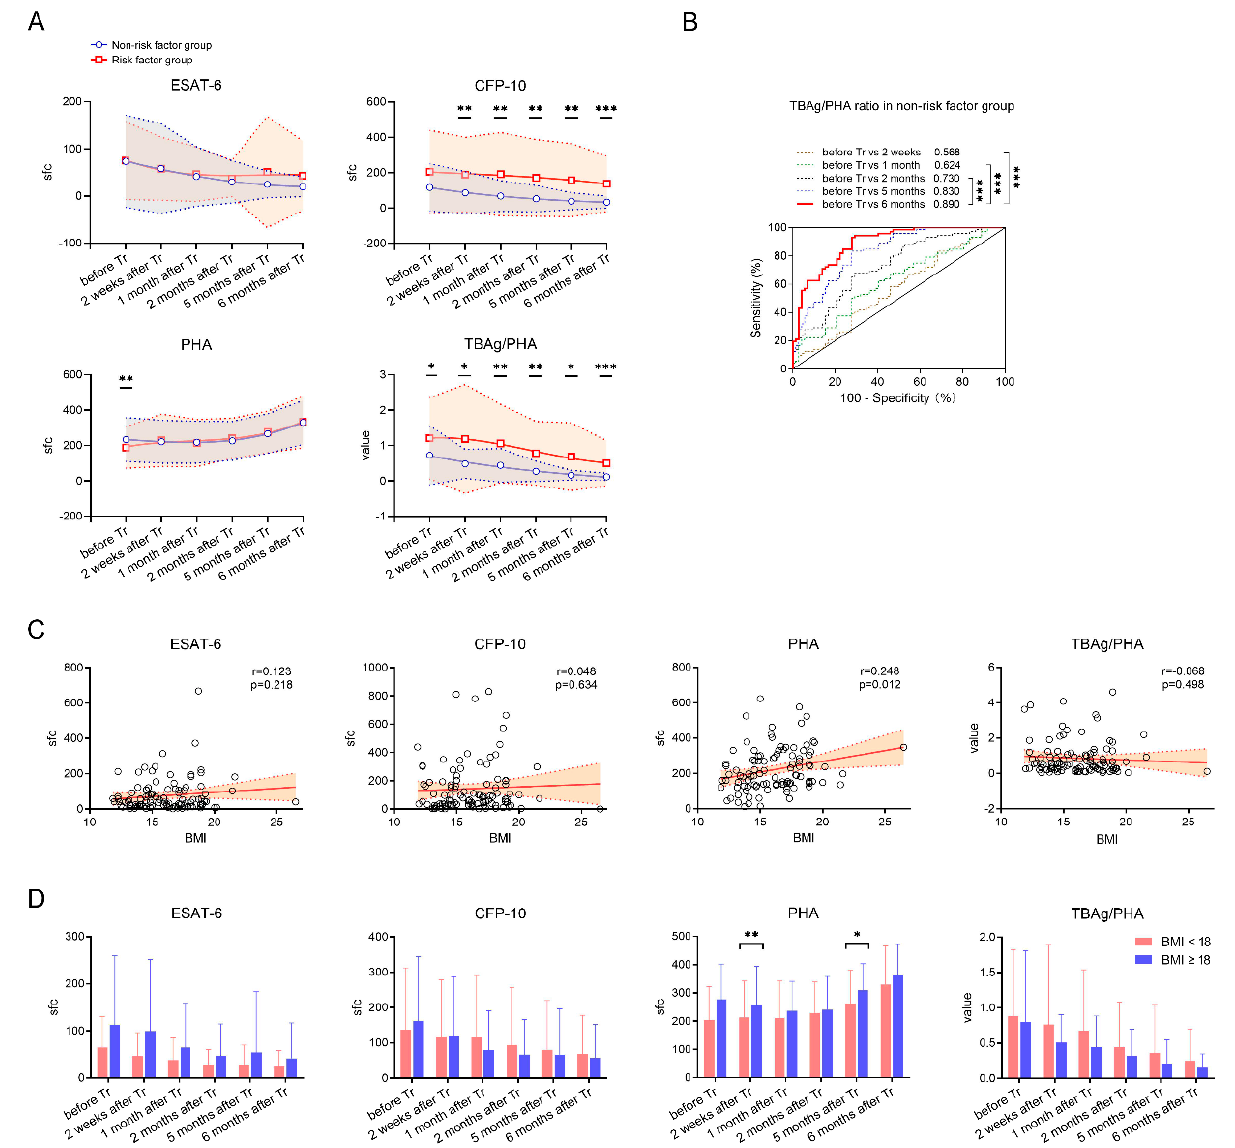
Figure 3. Classification groups in patients with successful treatment outcomes. ( A ) Dynamic analysis of the T-SPOT results in patients with and without risk factors after TB treatment. Data in each time point are expressed as mean ± SD (* p < 0.05, ** p < 0.01, and *** p < 0.001, between patients with and without risk factors in each time point). The smoothing cubic splines were fitted to the values of different parameters to summarize the overall trend. ( B ) Receiver operating characteristic analysis was performed for the TBAg/PHA ratio to determine threshold values for distinguishing between before treatment and after different time points of treatment. *** p < 0.001. ( C ) Correlation between T-SPOT results (ESAT − 6 sfc, CFP − 10 sfc, PHA sfc, and the TBAg/PHA ratio) and BMI in patients before treatment. ( D ) Bar graphs showing ESAT − 6 sfc, CFP − 10 sfc, PHA sfc, and the TBAg/PHA ratio in patients with BMI ≥ 18 and BMI < 18 at different time points after treatment. * p < 0.05, ** p < 0.01. ESAT − 6, early secreted antigenic target 6; CFP − 10, culture filtrate protein 10; PHA, phytohemagglutinin; sfc, spot-forming cells. TBAg/PHA, the ratio of TB-specific antigen to phytohemagglutinin. BMI, body mass index.